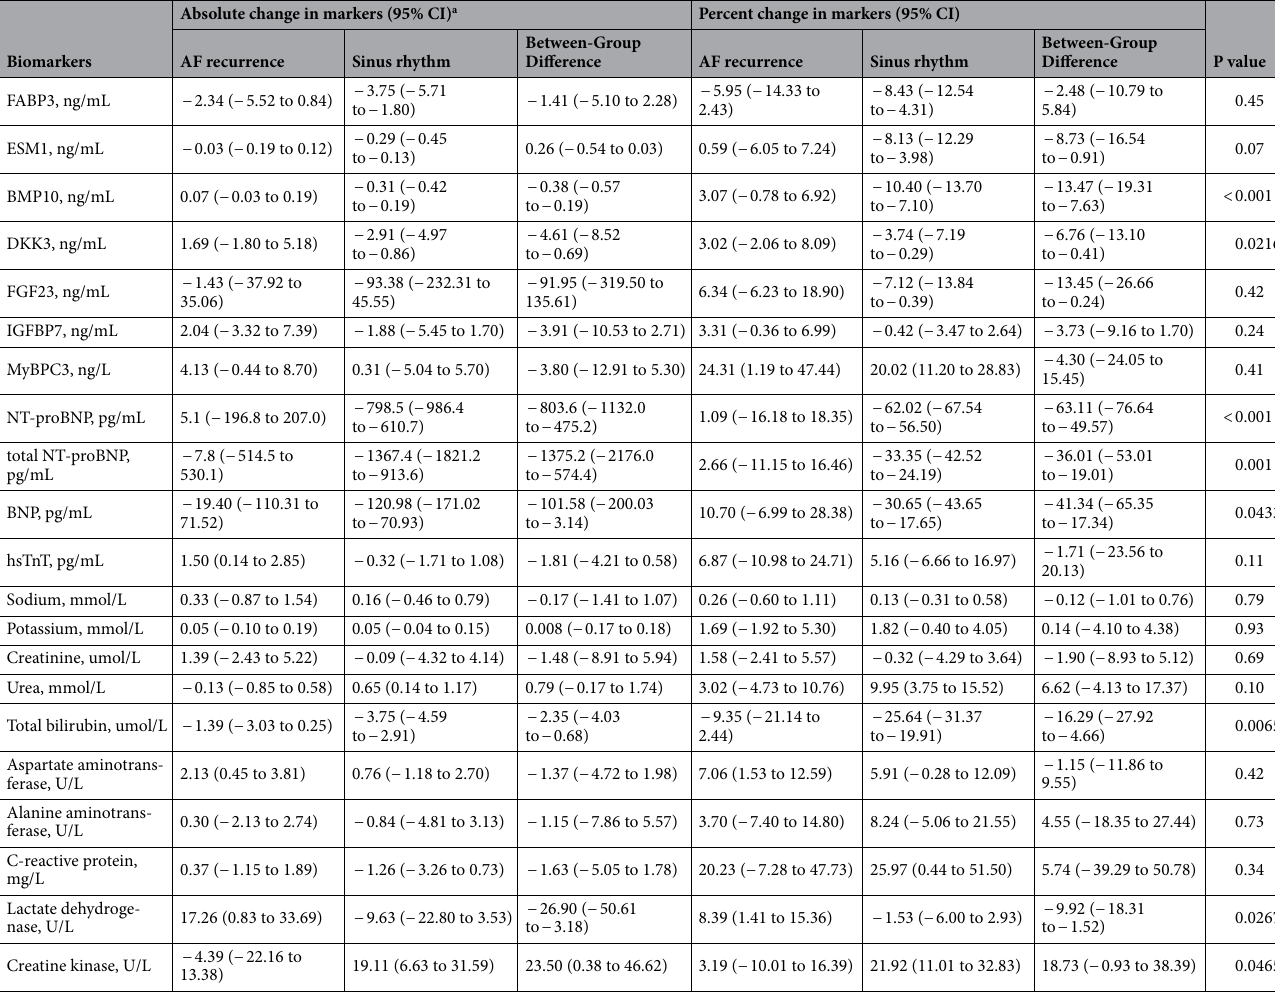
Table 3. Changes in biomarker concentrations by rhythm status at follow-up. FABP3 fatty acid binding protein 3, ESM1 endothelial cell-specific molecule-1, BMP10 bone morphogenetic protein 10, DKK3 , dickkopf related protein-3, FGF23 fibroblast growth factor 23, IGFBP7 insulin growth factor binding protein-7, MyBPC3 myosin-binding protein C, NT-proBNP N-terminal pro-B-type natriuretic peptide, BNP brain natriuretic peptide, hsTnT high-sensitive troponin T. a Mean difference with corresponding 95% confidence intervals.